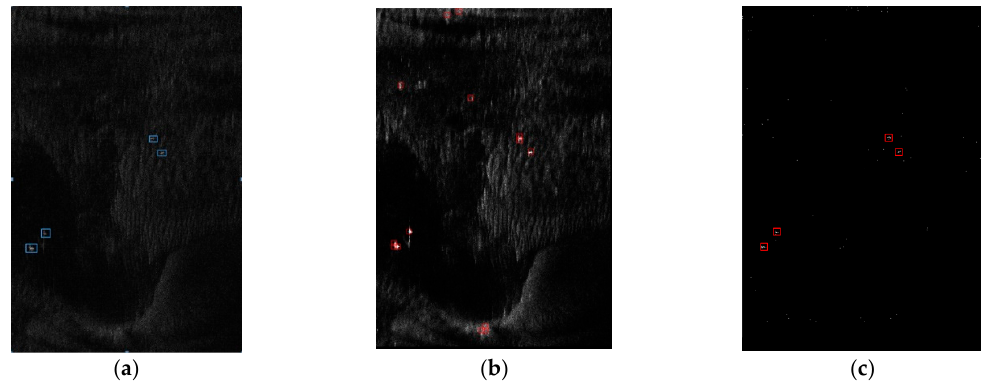
Figure 11. Results of the various methods on sub-images #1. ( a ) Detected result of the proposed method; ( b ) Detected result of the SLS-CNN method; ( c ) Detected result of the TF-ANN method.